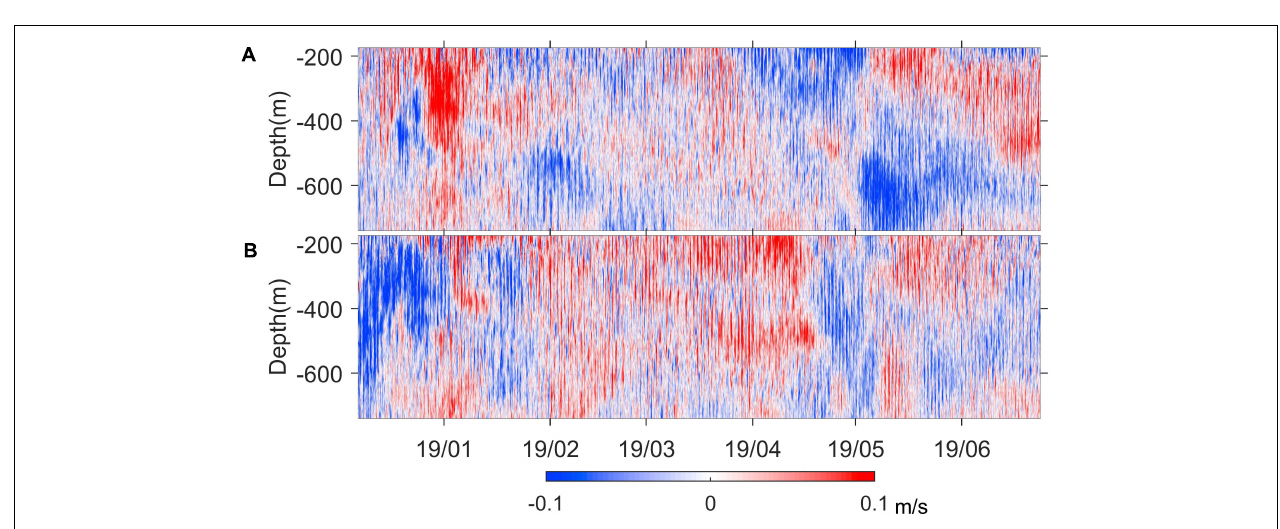
FIGURE 1 | Topography of the south of the South China Sea (A) , using the topographic data obtained from ETOPO1 (https://www.ngdc.noaa.gov/mgg/global/global.html). The black triangle is the mooring station. Zonal topography and observing profile of the mooring station (B) , where the water depth is 1,350 m. The 75 kHz up-looking ADCP was positioned at 750 m, measuring the velocity from 157 to 741 m.